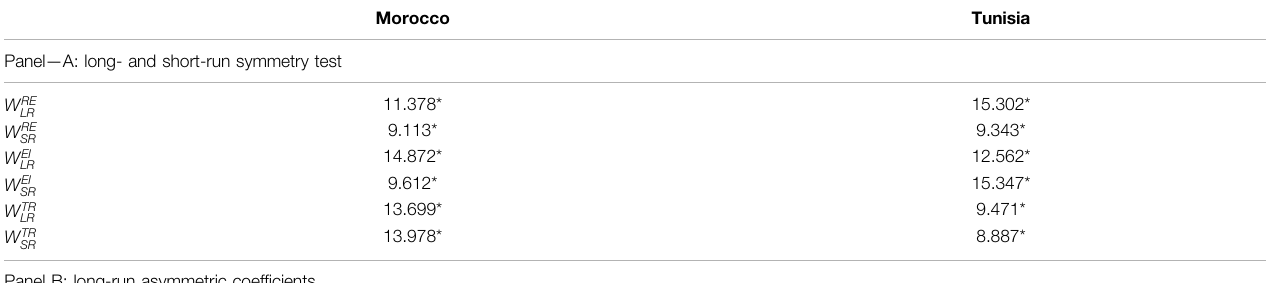
TABLE 9 | Long- and short-run coef fi cient with asymmetric estimation.